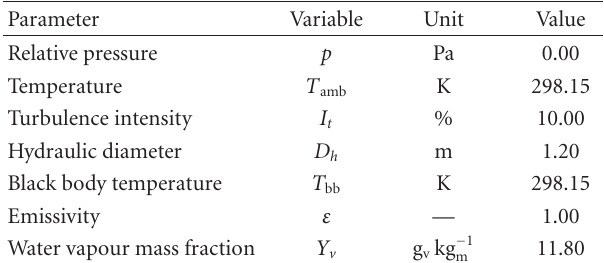
Table 3: Values imposed at the fixed pressure boundary